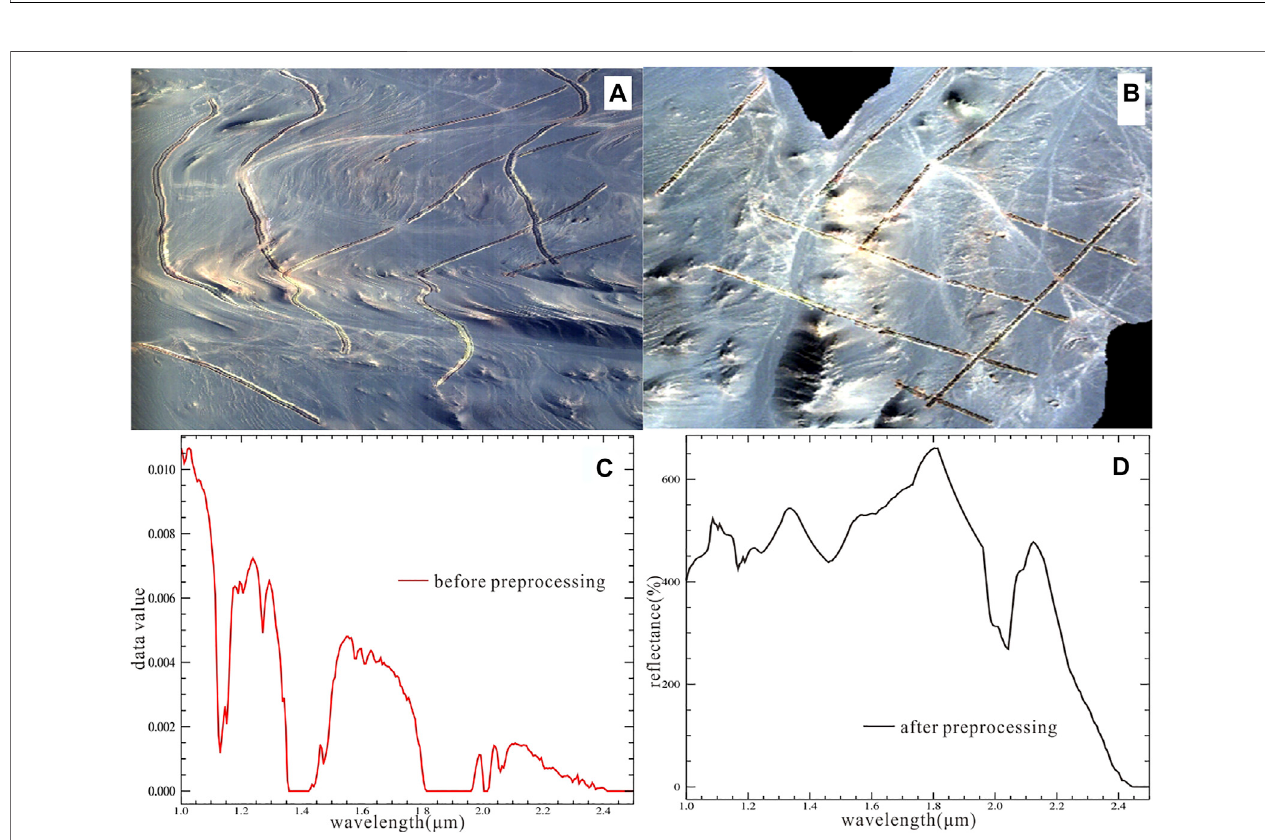
Frontiers in Earth Science |